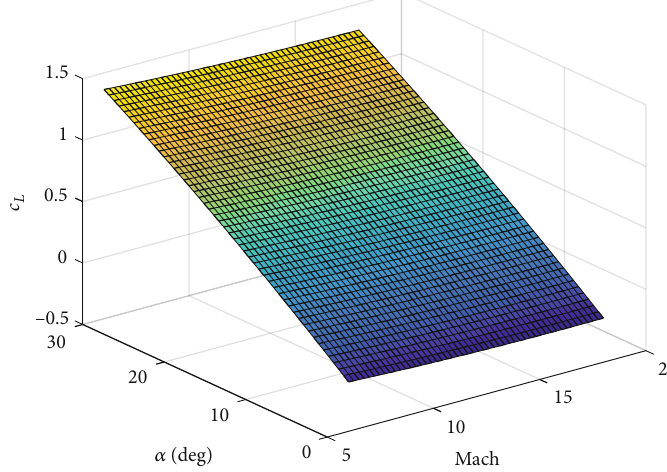
Figure 2: Lift coe ffi cient with respect to the Mach number and angle of